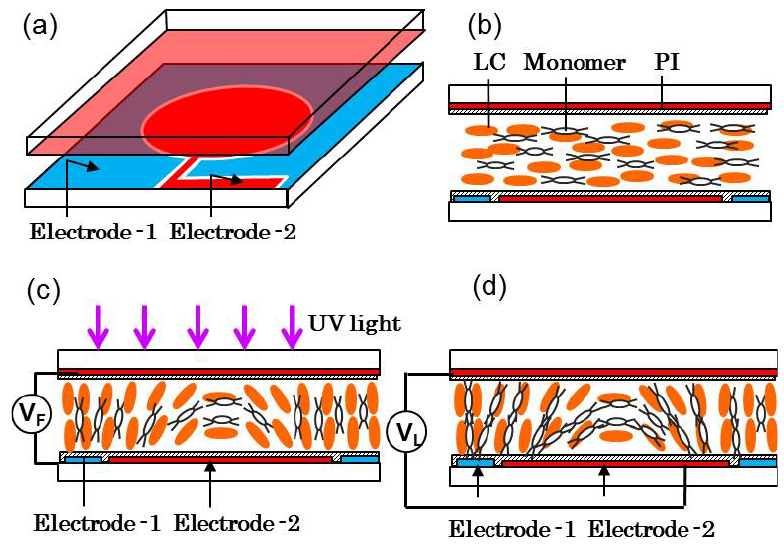
Figure 4. PNLC microlens structure and fabrication procedures: ( a ) microlens structure; ( b ) LC/monomer mixture present a homogeneous alignment; ( c ) central-symmetric gradient refractive index distribution is introduced by inhomogeneous fringe field along with UV exposure and ( d ) the formed PNLC microlens after removing the voltage is actuated by a uniform longitudinal electric